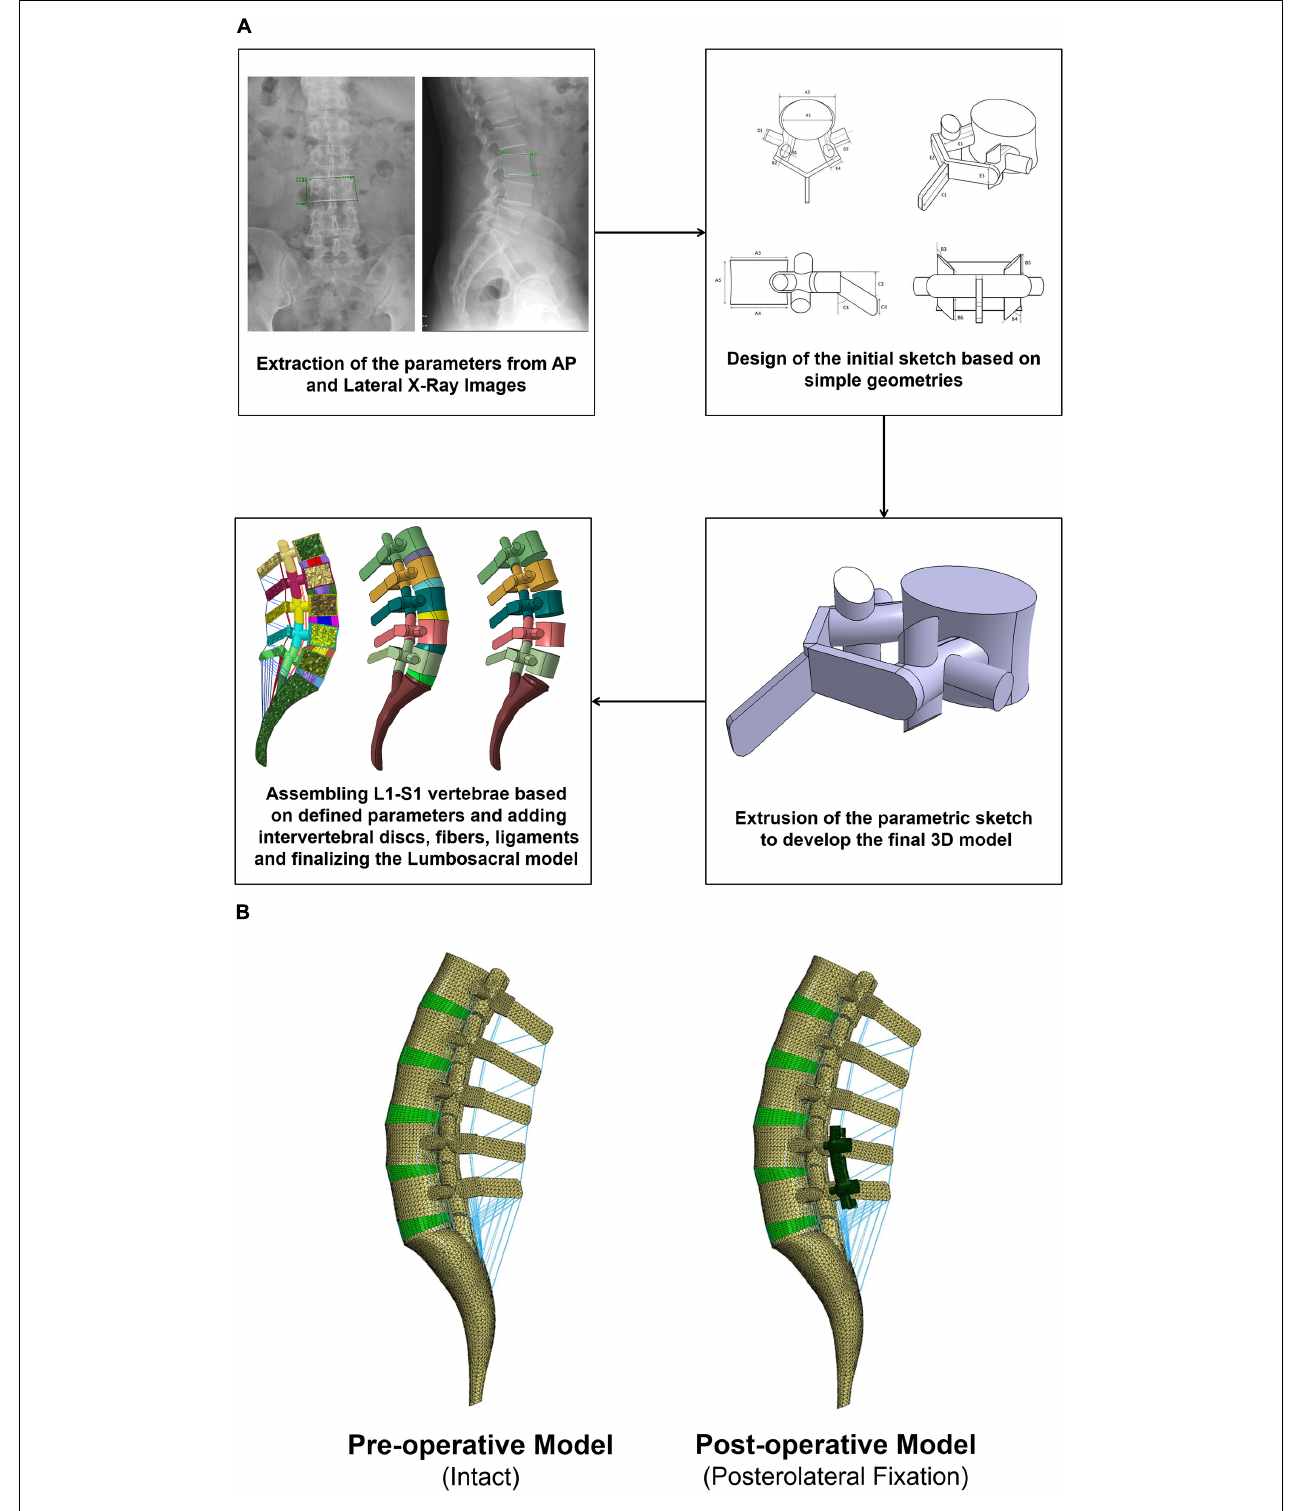
FIGURE 1 | (A) Procedure of personalized poroelastic finite element (FE) modeling of the lumbosacral spine and (B) preoperative (intact) and postoperative (posterolateral fixation) FE models.